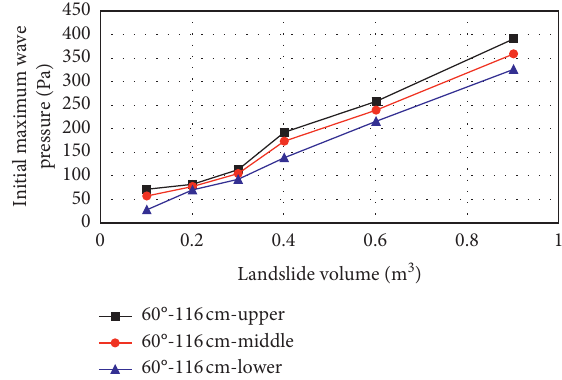
Figure 10: Variation of initial maximum wave pressure at upper, middle, and lower measuring points with landslide volume (60 ° ,